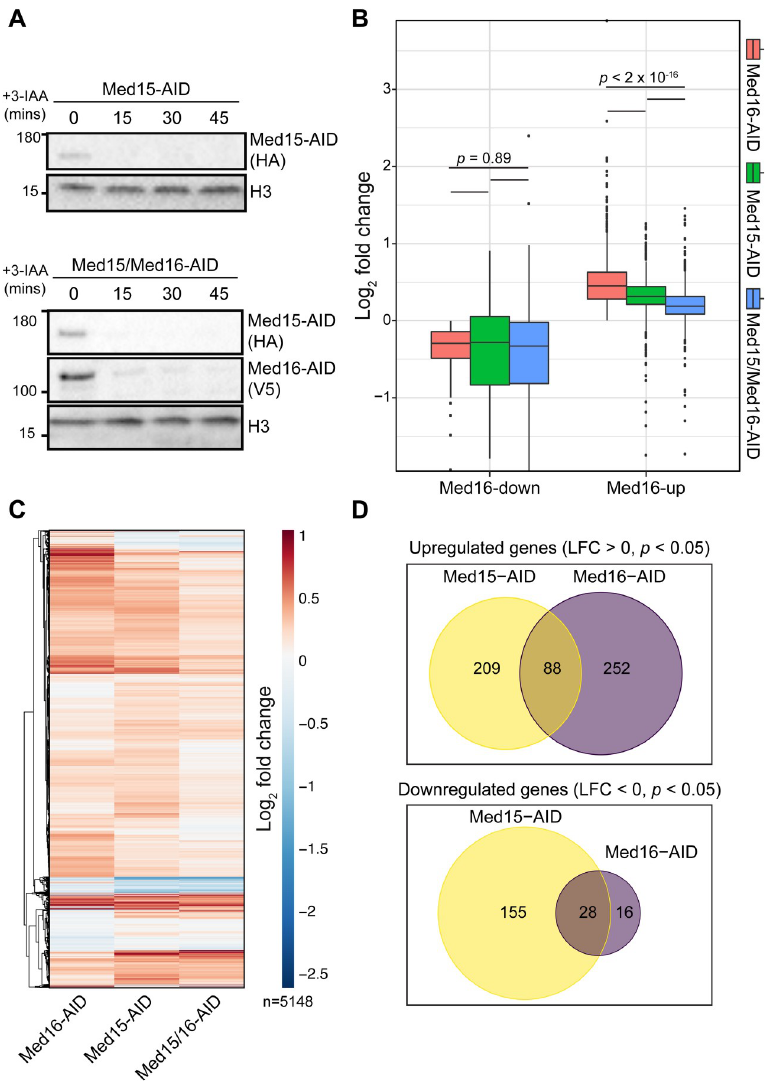
Fig 3. Transcription overactivation by Med16 removal is partially dependent on the tail triad. (A) Western blots showing the kinetics of Med15-AID and Med16-AID depletion upon 3-IAA treatment of single or double-degron cells. (B) Boxplots of log 2 fold changes in nsRNA levels of transcripts produced from Med16-AID downregulated and upregulated genes for the Med15-AID, Med15/16-AID, and Med16-AID 3-IAA versus DMSO comparisons. Statistical differences between groups were assessed by pairwise Wilcoxon rank-sum test with Holm correction for multiple testing. (C) Hierarchically clustered heatmap of log 2 fold changes in nsRNA levels of transcripts produced from 5,148 genes encoding verified ORFs for the Med15-AID, Med15/16-AID, and Med16-AID 3-IAA versus DMSO comparisons. (D) Venn diagrams of overlap between genes significantly upregulated or downregulated in the Med15-AID and Med16-AID